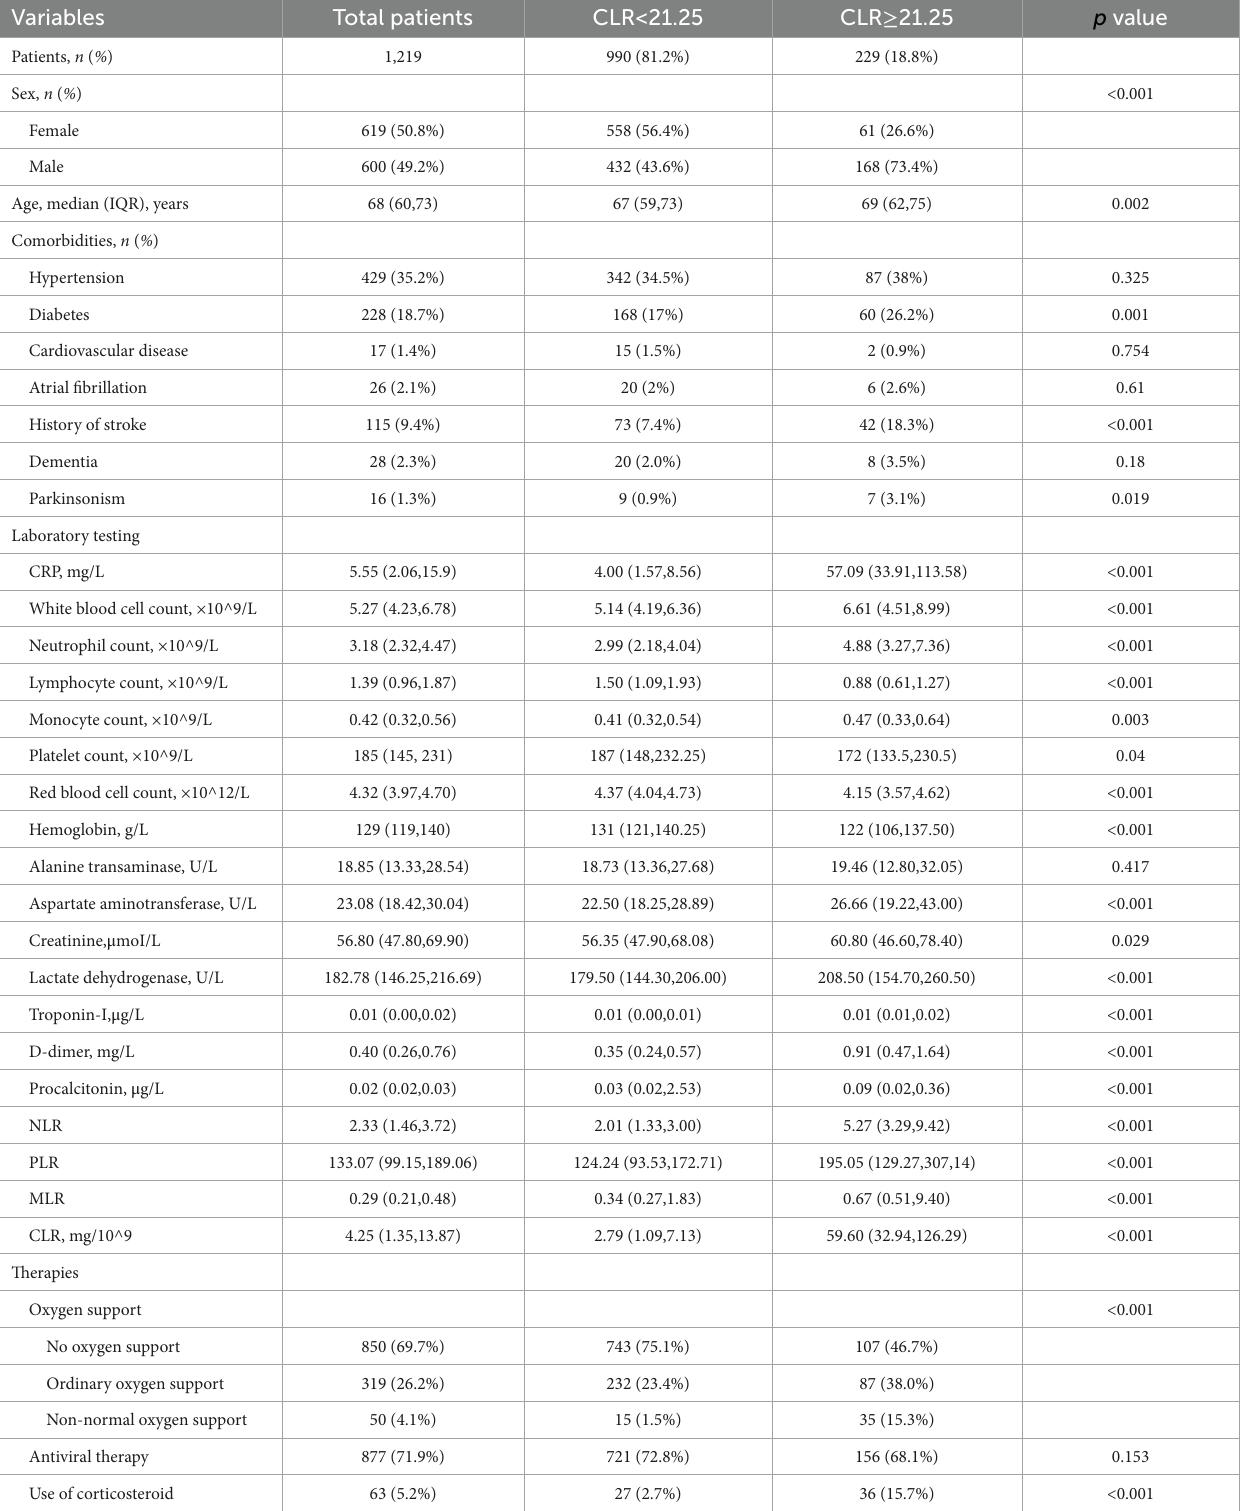
TABLE 3 Baseline characteristics of patients stratified by CLR.